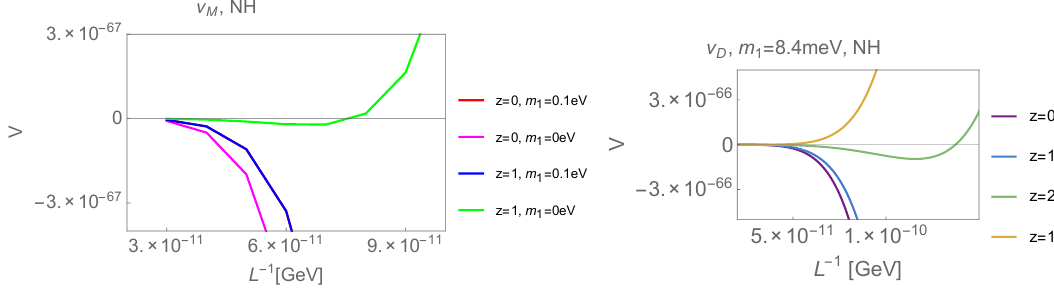
Figure 6 . The radion potential around the neutrino mass scale for NH. Here the scale L 0 is taken to be 1 GeV (cid:0) 1 . The potential is same as that in (cid:12)gure 4, but the vertical axis is the potential V itself, and the horizon axis is the small segment of L (cid:0) 1 around the neutrino mass scale. As in (cid:12)gure 4, for the Majorana case, the z = 1 plots correspond to AdS minima. For the Dirac case, z = 1 and z = 2 = 3 correspond to the (cid:13)at and AdS minima, respectively. smaller (larger) m . Explicitly, AdS is obtained for 8 : 4(3 : 1) meV . m and dS 3 3 (cid:23); lightest (cid:23); 1(3) . 8 : 4(3 : 1) meV for NH is obtained for 7 : 3(2 : 5) meV . m (cid:23); 1(3)